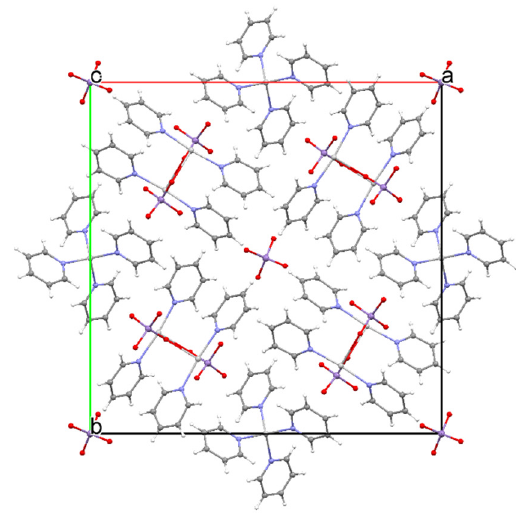
Figure 8. Structure and packing of compounds 4a and 4b [9].